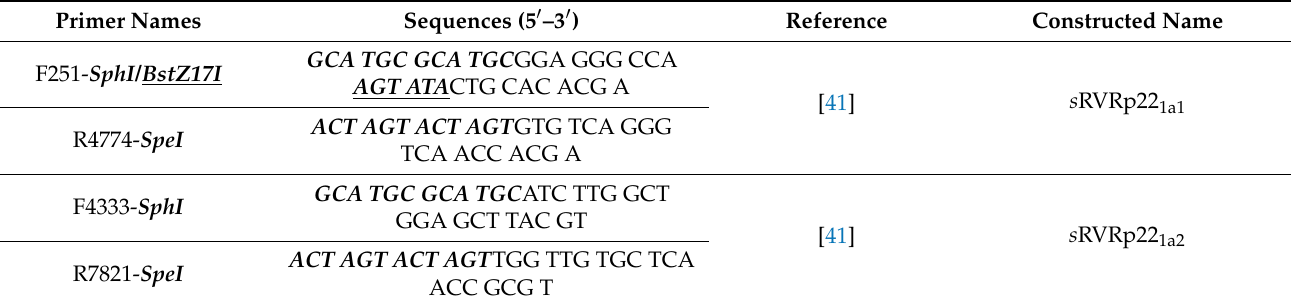
Table 1. Shuttle vector s RVRp22 1a ( s RVRp22 1a1 + s RVRp22 1a2 ) construction primers.